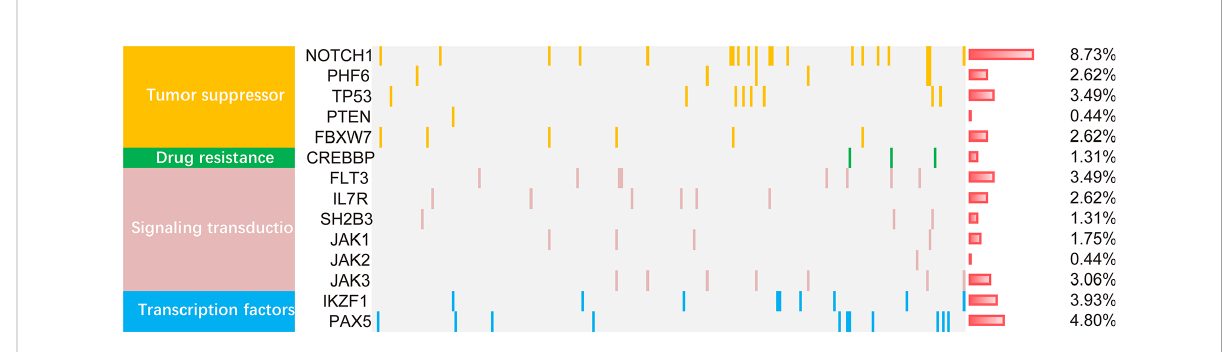
FIGURE 2 The mutational landscape of 229 ALL patients. The landscape displayed all genetic anomalies for each subject. A single patient instance was represented by the boxes in one column. Mutations were color coded according to mutation type. The frequency distribution of all aberrations was depicted by the histogram on the